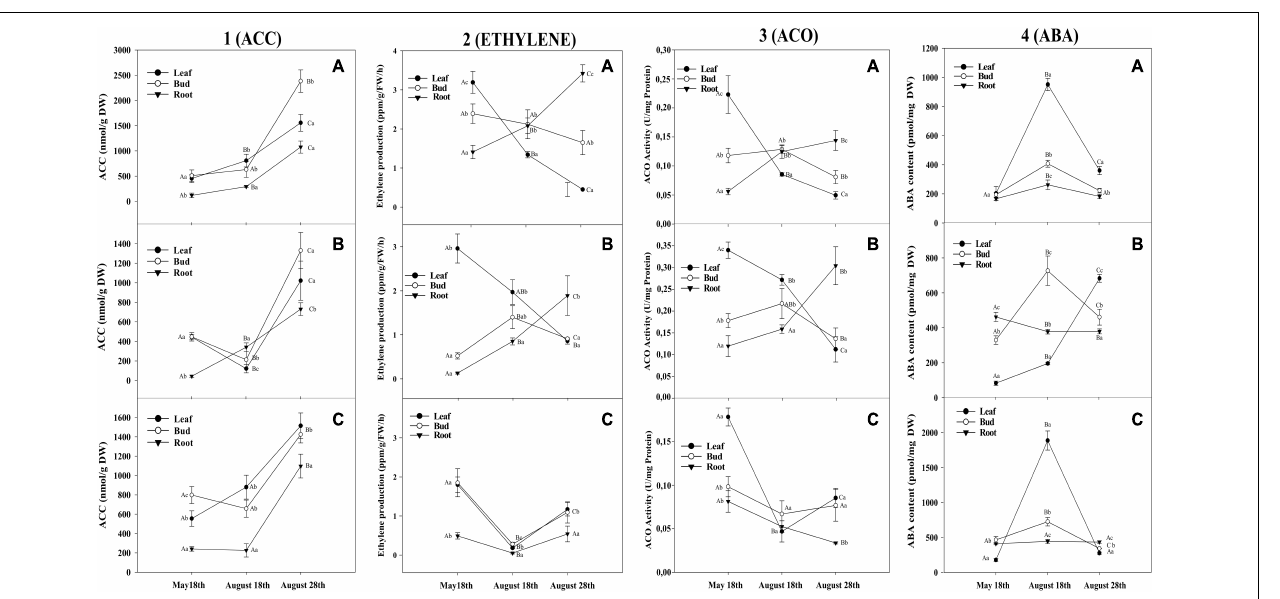
FIGURE 2 | Plant hormones evolution for coffee genotypes. 1-aminocyclopropane-1-carboxylate (ACC) content (1) , Ethylene production (2) , ACC oxidase (ACO) activity (3) , and abscisic acid (ABA) content (4) in leaves, flower buds, and roots from (A) Oeiras, (B) Acauã, and (C) Semperflorens plants at the rainy period (May 18th), at the dry period (August 18th), and after rain in the re-watering period (August 28th). Data are means ± 95% SD of the mean ( n = 6). Different upper-case and lower-case letters indicate the statistical difference of each tissue among the different periods and different tissues within the same period,